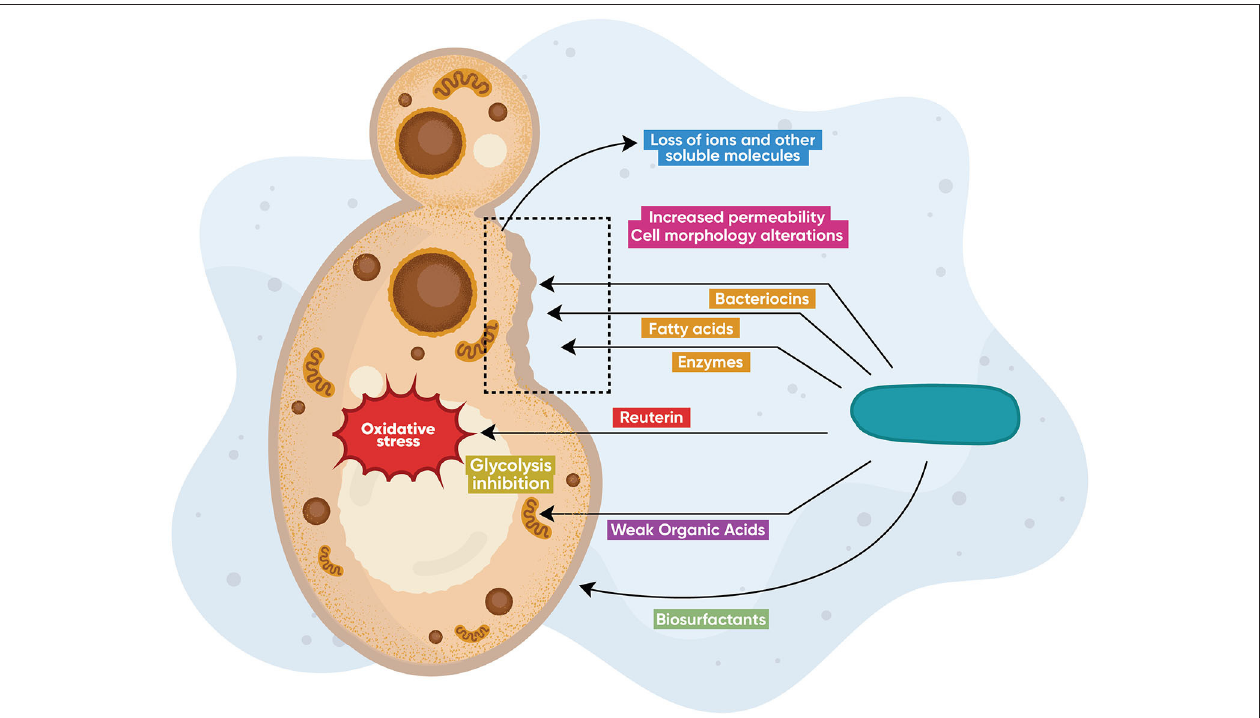
FIGURE 1 | Direct antifungal modes of action. Lactobacillus species produce diverse metabolites including bacteriocins, enzymes (chitinases), hydrogen peroxide, fatty and other organic acids, as well as proteinaceous molecules (reuterin), that exert direct anticandidal activity via different mechanisms of action. Some metabolites alter the physiology of the fungus by inducing oxidative stress or by ATP depletion leading to cytotoxicity or growth inhibition. Other metabolites compromise the structural integrity of the fungal cell leading to alterations in cell morphology, membrane permeability, and death, while biosurfactants prevent adhesion to mucosal